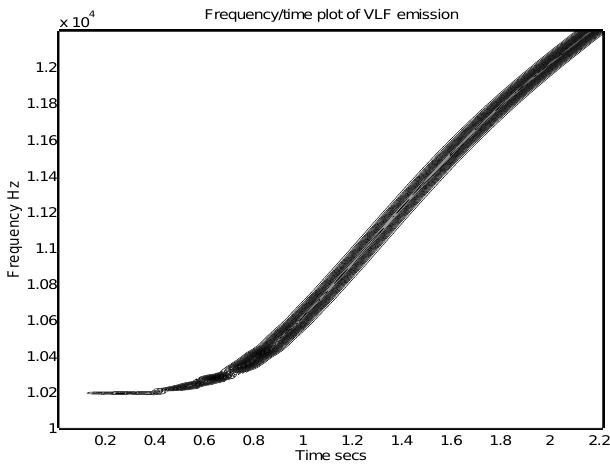
Fig. 6. Run 1. Omega triggered riser. Frequency time spectrogram of the wave field data stream exiting from the interaction region. Actual numerical values are